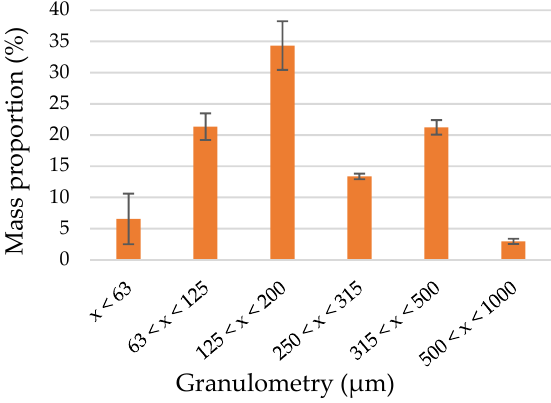
Figure 1. Particle size distribution of the heartwood.